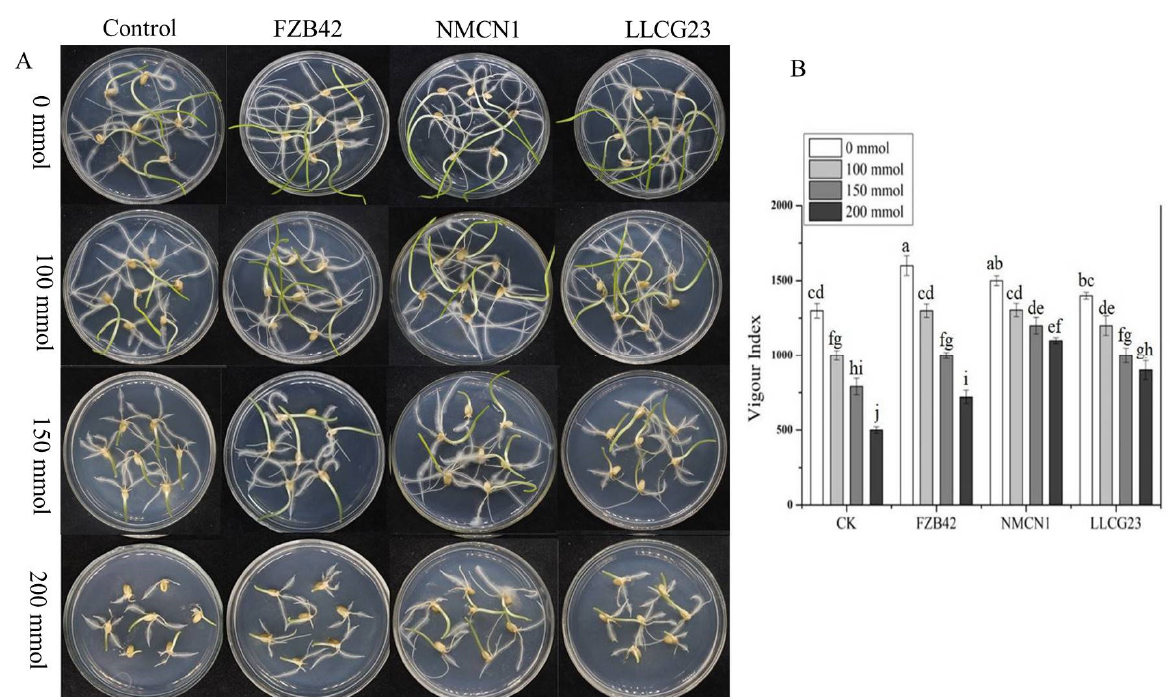
Figure 4. Wheat seedlings inoculated with Bacillus strains FZB42, NMCN1 and LLCG23 were grown for 7 days at 25 °C under different NaCl concentrations (0 mmol–200 mmol). ( A ) The visual repre- sentation showing the effect of selected strains on wheat growth promotion under different saline conditions. ( B ) The calculation of seedlings’ length and percent germination is represented in graph as vigour index for wheat seeds treated with different Bacillus strains as compared with control (seeds without bacteria). The bars on the column represent mean standard deviation ( n = 3). The small letters on the bars indicate significant difference among the treatments calculated through Tukey’s HSD test at p ≤ 0.05 and the experiment was repeated thrice with three replicates for each treatment.